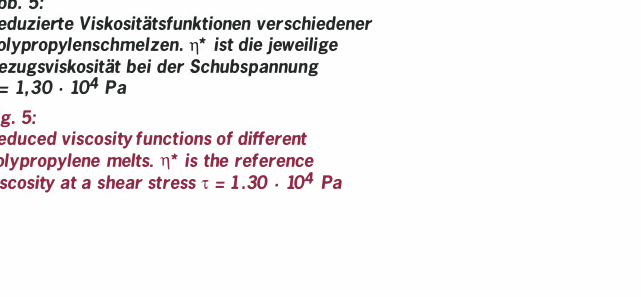
reference value used in the viscosity 11 *(1:;), which is that viscosity determined at the shear stress 't;. One result of this normalization method is that the values of the reduced viscosity function will exceed the value of unity at very small reduced shear rates, Y11 *. Based on this modified invariant depiction, any viscosity functions can be compared with one another as